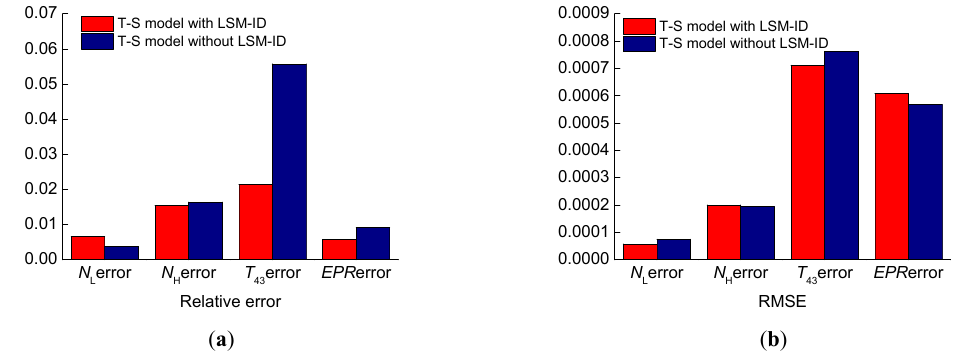
Figure 12. Relative error and RMSE compared with the nonlinear model under 10.5 km and 1.22 Mach. ( a ) Relative errors. ( b ) RMSEs.